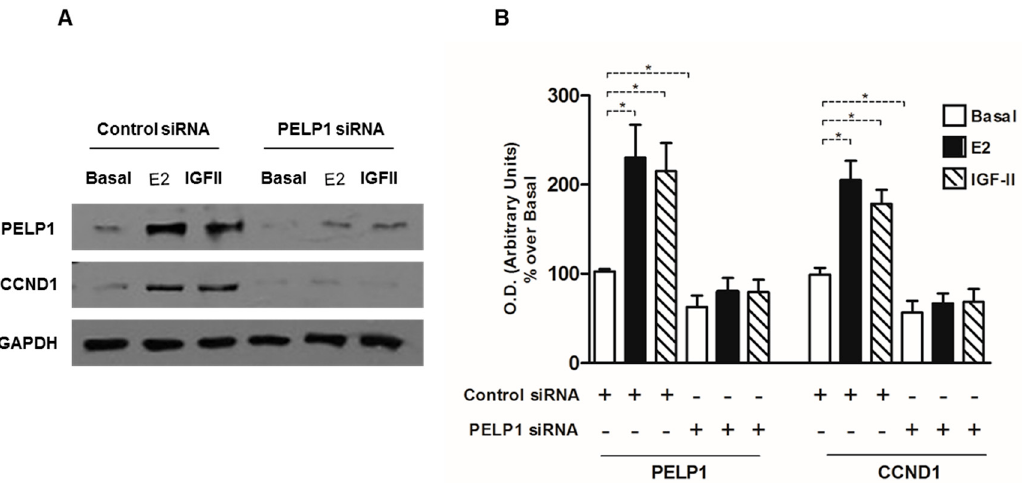
Figure 5. PELP1 knockdown decreases Cyclin D1 expression in H295R cells. Cells were transfected with PELP1 siRNA or a non-targeting siRNA (control siRNA) for 24 h. After transfection cells were treated for 24 h with E2 (100 nM) and IGF-II (100 ng/mL). Western blot analyses of Cyclin D1 were performed on 50 µ g of total protein. Results are representative of at least three independent experiments. GAPDH was used as a loading control; the right panel graph represents mean of Cyclin D1 optical density (O.D.) from three independent experiments with similar results normalized to GAPDH content (* p < 0.001 compared to untreated control sample (Basal) assumed as 100).